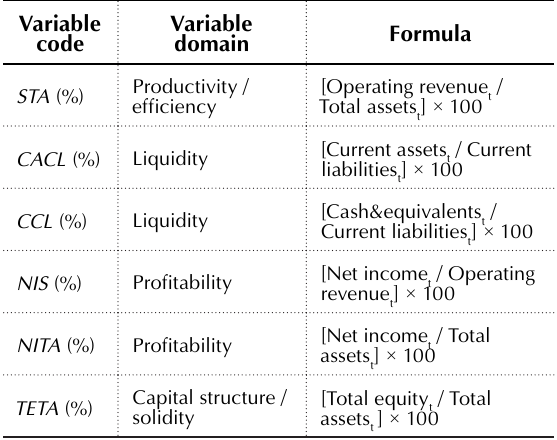
Table 1. Formulae of financial ratios applied in the